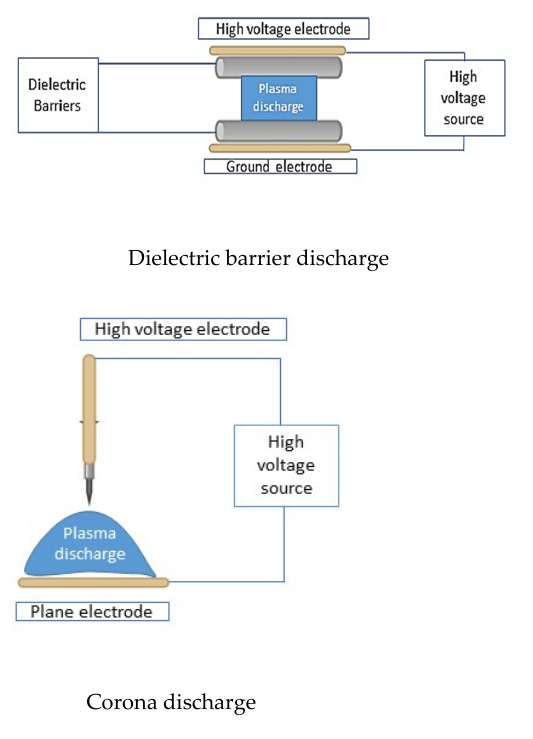
Figure 1. Some configurations of cold plasma systems.